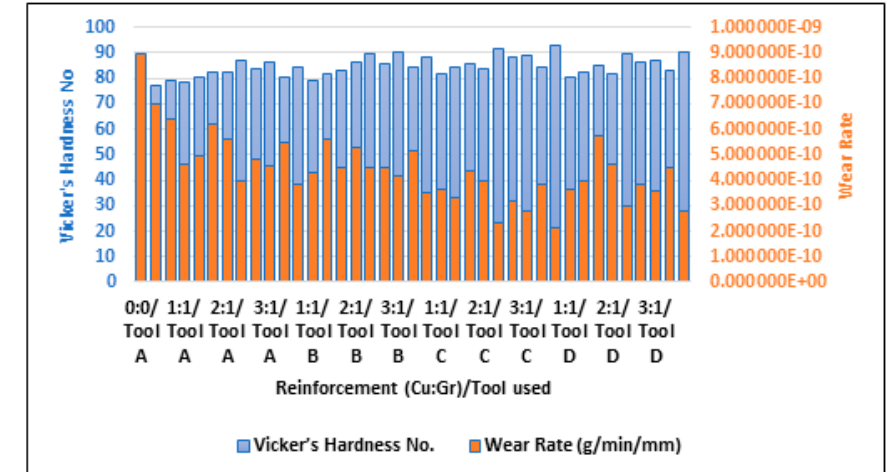
Figure 11. Comparison of wear rate and Vicker’s hardness number (HV) of the composites.